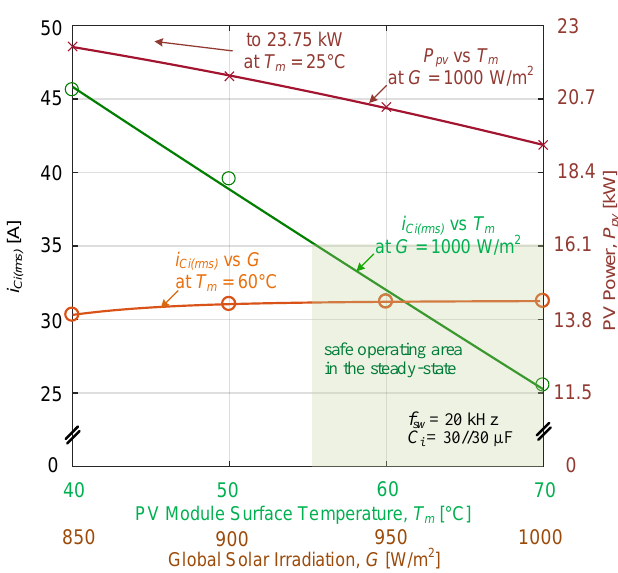
Figure 13. Effects of PV module surface temperature and global solar irradiation on i ci ( rms ) for 20 kHz switching frequency (these theoretical results were obtained from the dynamic model in Figure 5b; i ci is defined in Figure 3a; C i = 30//30 µ F is assumed; variations in power delivered by the multi-string PV system in Figure 2 against PV module surface temperature are also given on this figure).